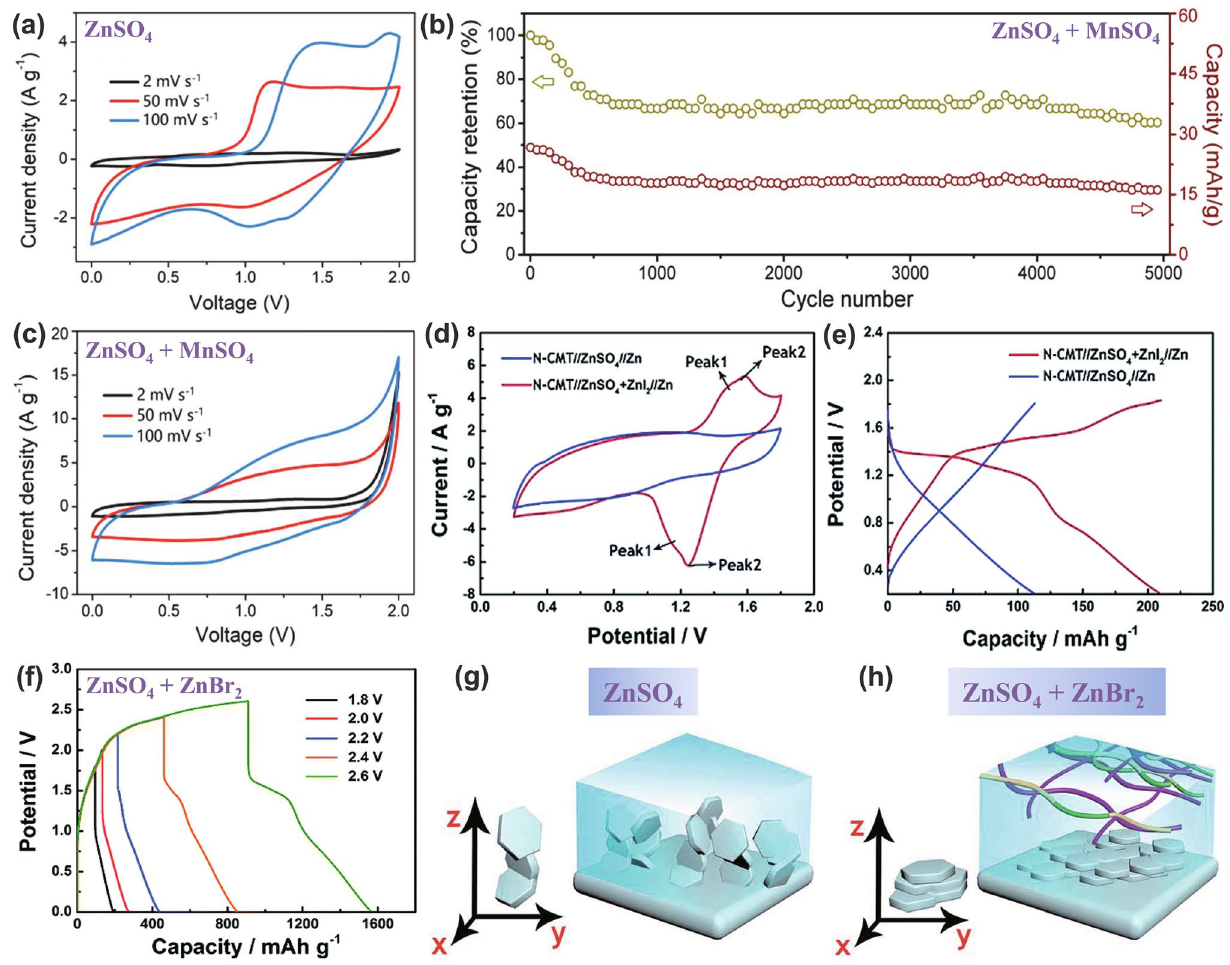
Fig. 11 a CV curves of AC//2.0 M ZnSO 4 // γ ‑MnO 2 ZHSCs. b Cycling performance and c CV curves of AC//2.0 M ZnSO 4 + 0.5 M MnSO 4 // γ ‑MnO 2 ZHSCs. Reproduced with permission from Ref. [188]. Copyright 2019, Elsevier. d CV curves and e GCD profiles of Zn//N‑ CMT ZHSCs in different electrolytes. Reproduced with permission from Ref. [110]. Copyright 2019, Royal Society of Chemistry. f GCD curves with diverse voltage windows. g , h Schematic illustration of Zn deposition in g ZnSO 4 and h SA‑Zn‑Br hydrogel electrolytes. Reproduced with permission from Ref. [198]. Copyright 2020, Royal Society of